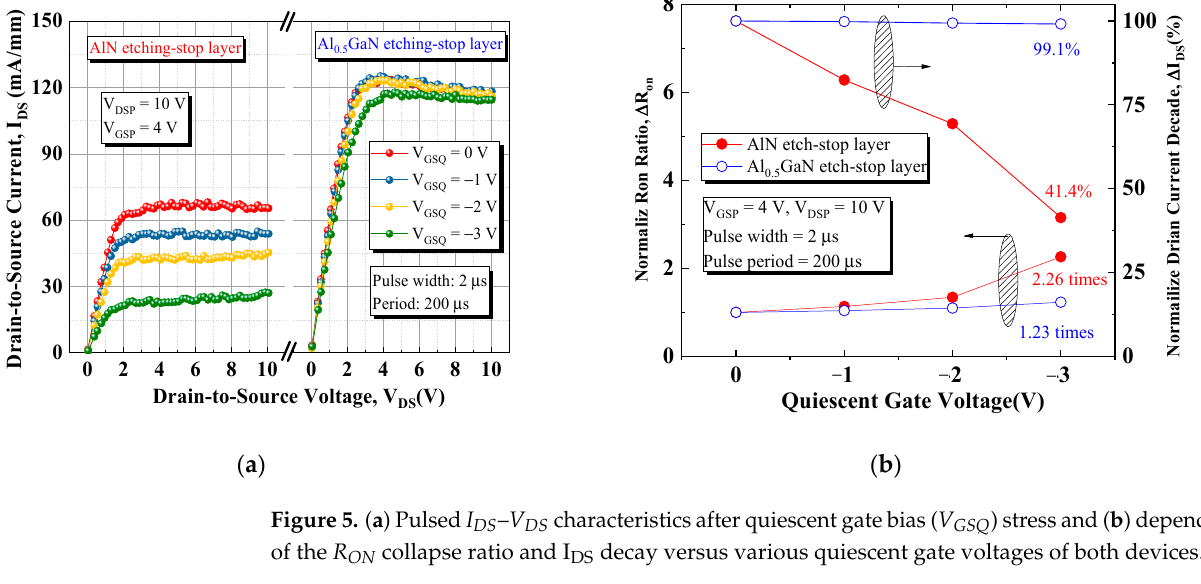
Figure 5. ( a ) Pulsed I DS – V DS characteristics after quiescent gate bias ( V GSQ ) stress and ( b ) dependence of the R ON collapse ratio and I DS decay versus various quiescent gate voltages of both devices.